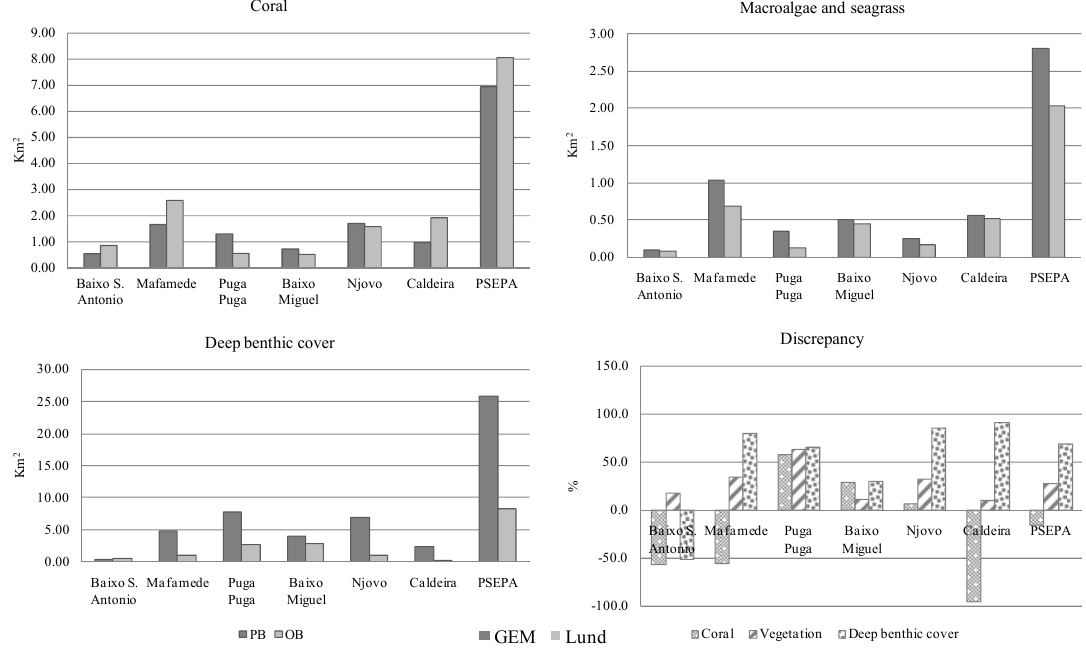
Figure 7. Extent of coral, vegetation and deep benthic cover according to the GEM and Lund maps.